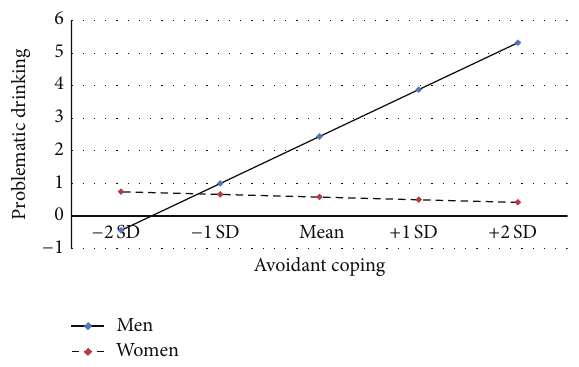
Figure 4: Gender contrasts in the effects of avoidant coping on problematic drinking. Notes: gender ∗ avoidant coping ( 𝛽 = −0.319 , s . e . = 0.021 , and 𝑃 < 0.001